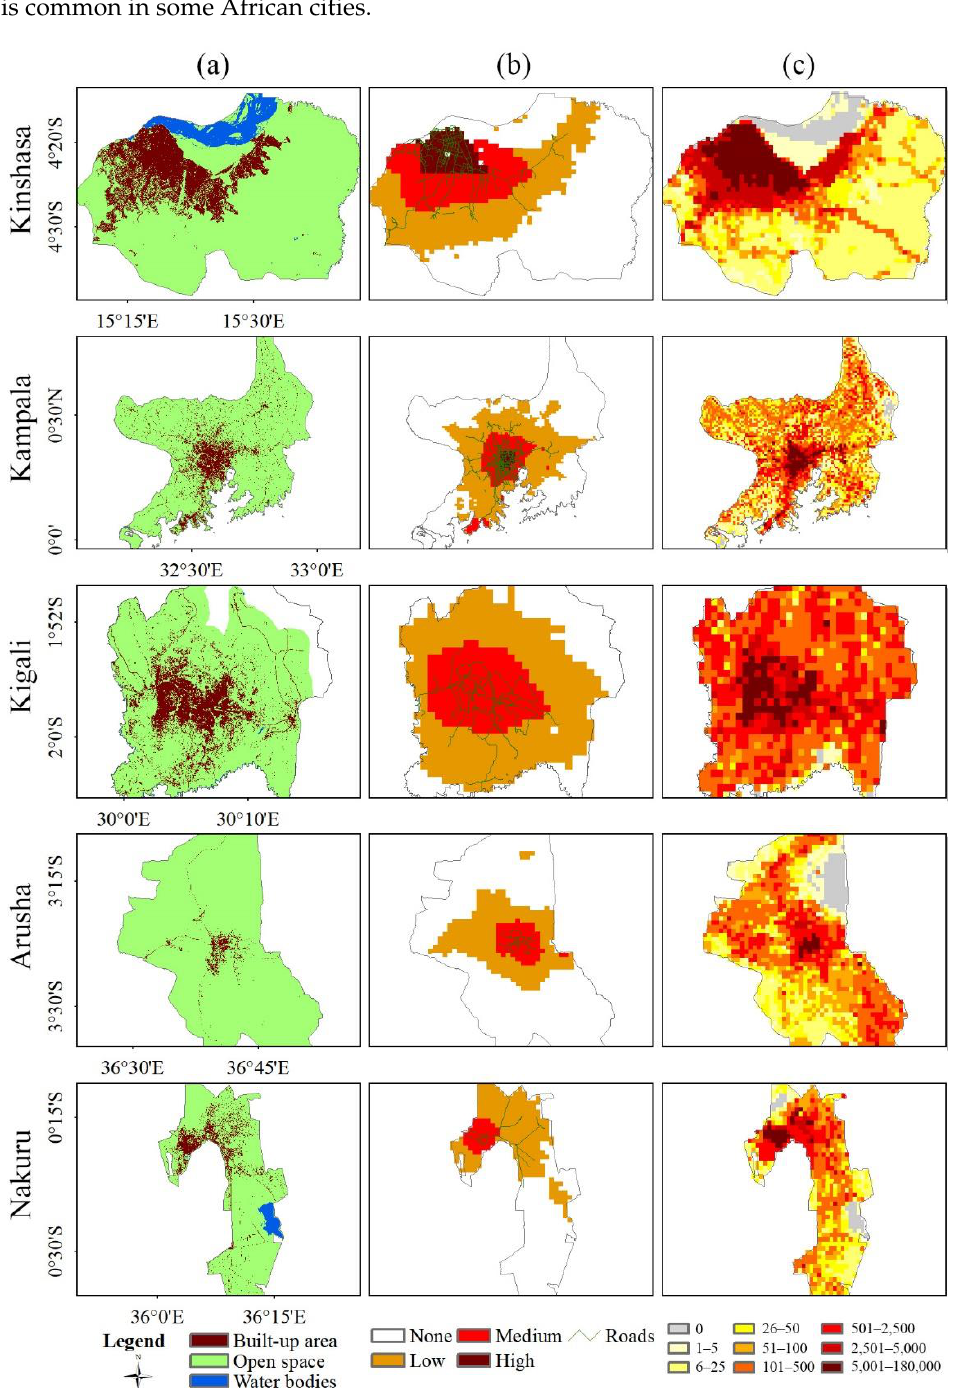
Figure 11. Representative poorly lighted cities ( a ) urban land use, ( b ) nighttime lighting areas and arterial roads, and ( c ) population density.